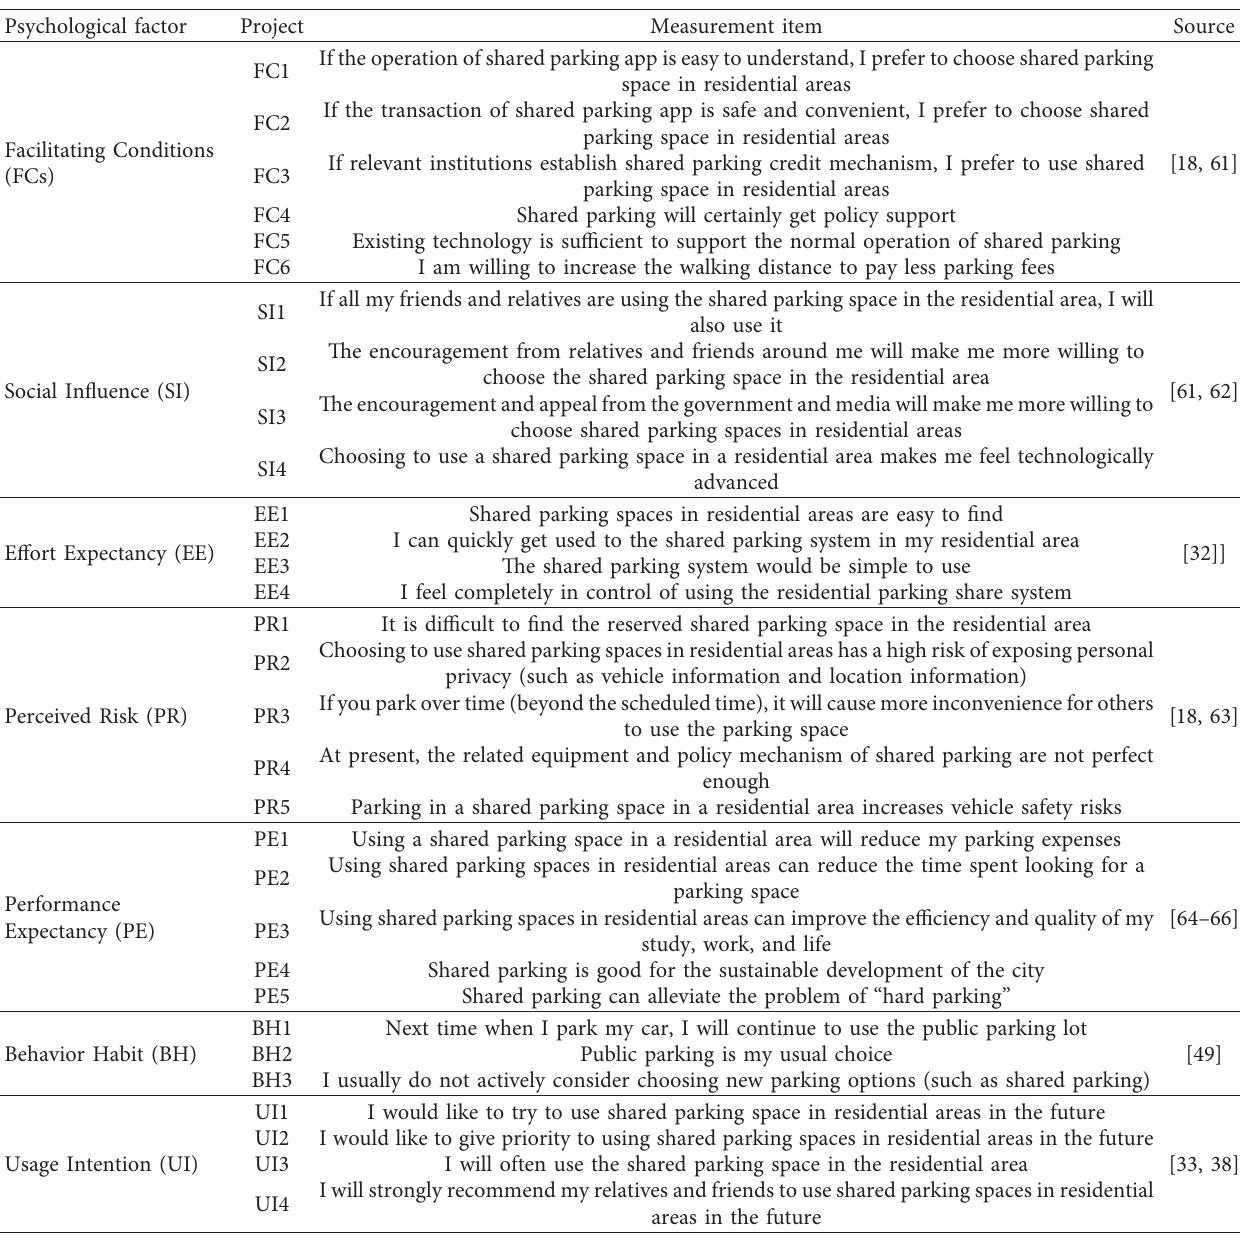
Table 1: Construction and measurement items of psychological